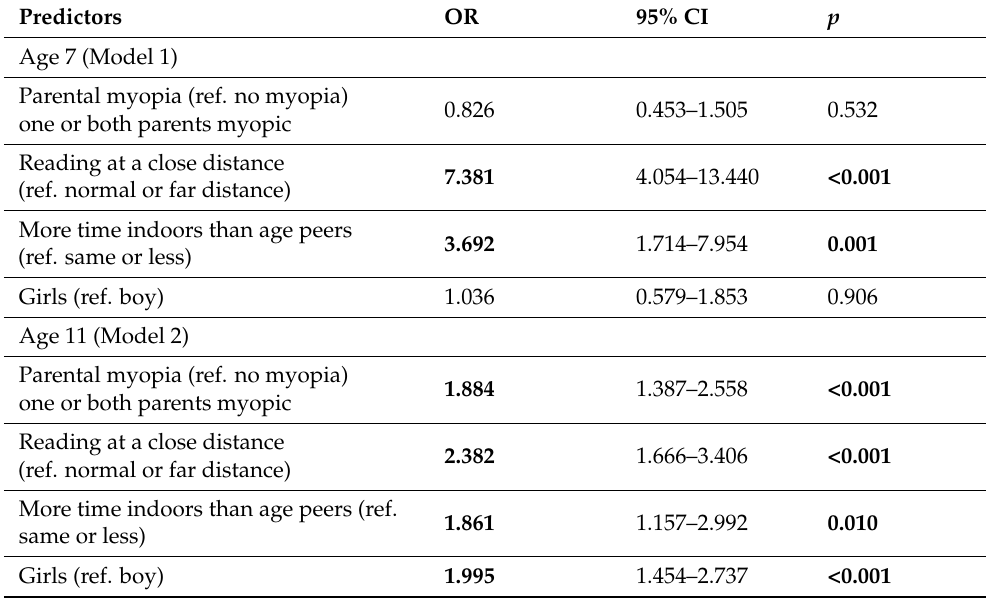
Table 5. Multiple logistics regression models (OR, 95% confidence intervals) for myopia in different age groups adjusted by three